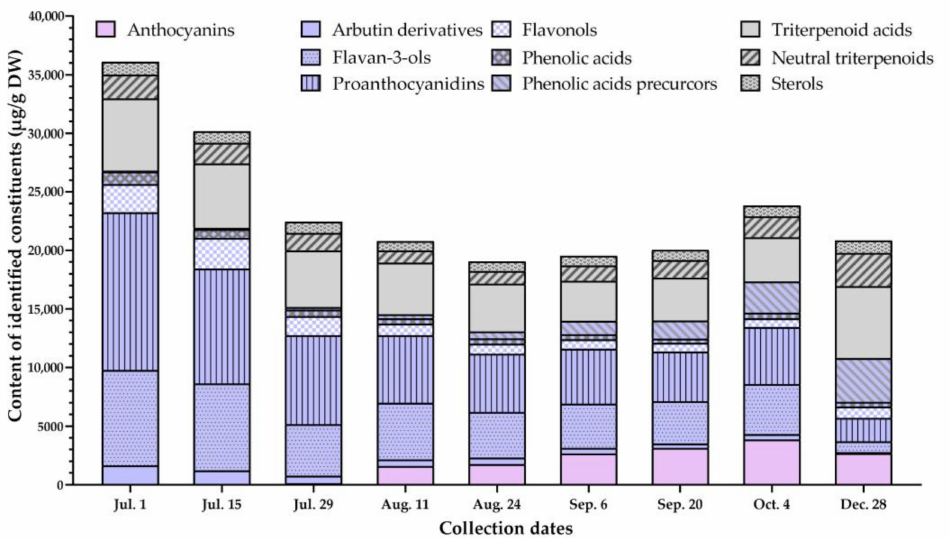
Figure 2. Variation of phenolics and triterpenoids in lingonberries ( µ g/g DW) during different phenological